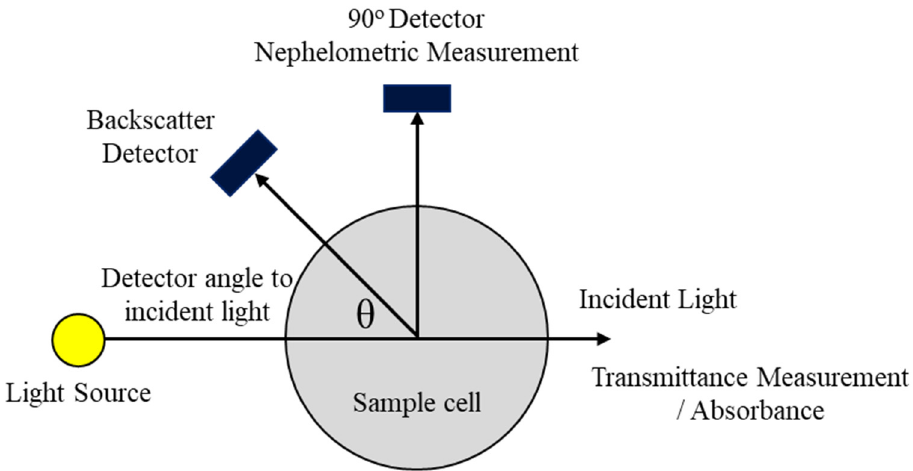
Figure 1. Turbidity Measuring Techniques.